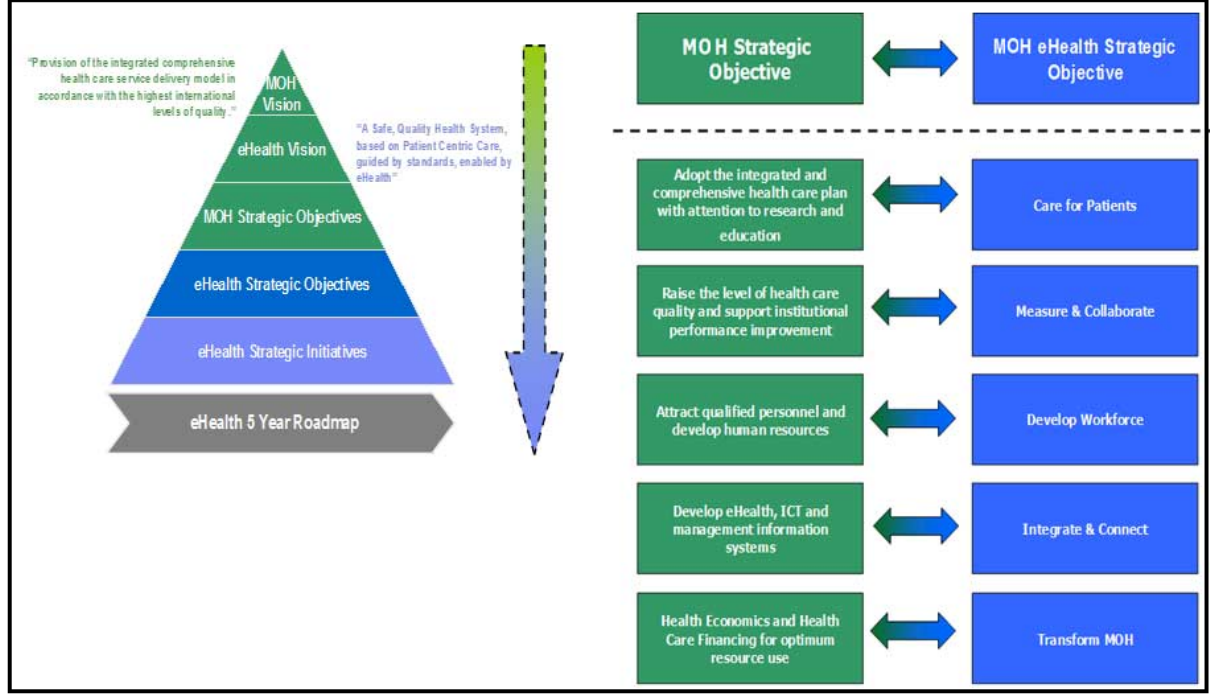
Figure 2. The National eHealth Strategy of Saudi Arabia. ICT: information and communications technology; MOH: Ministry of